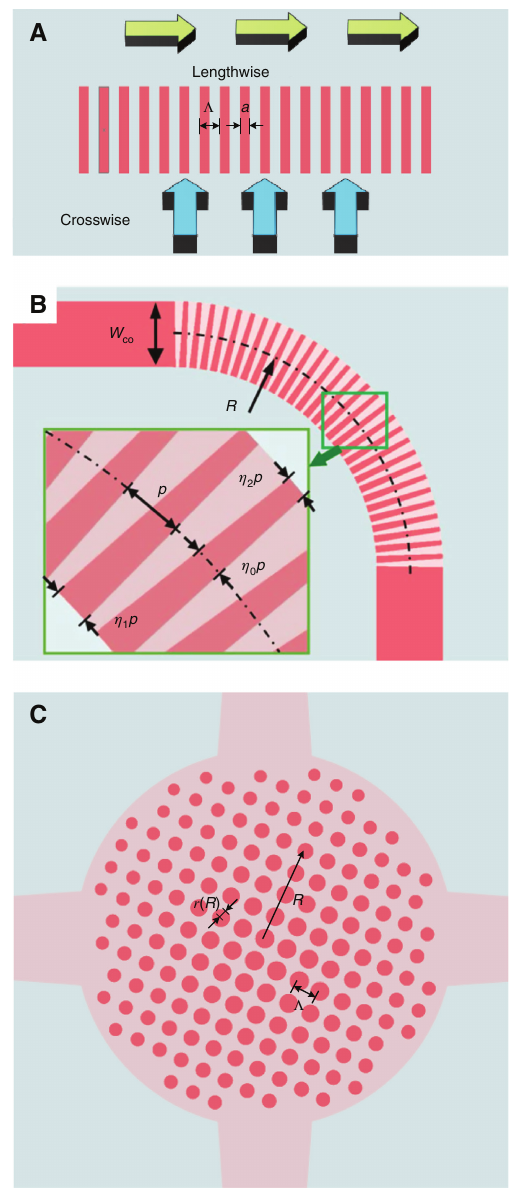
Figure 1: Schematic diagrams of various subwavelength structured strip and slab waveguides. (A) SWG waveguide, (B) 90 ° waveguide bend, and (C) multimode crossing based on the subwavelength metamaterial. The red, pink, and gray colors represent silicon, partially etched silicon, and silica, respectively. B is reprinted from Wu et al. [12]. reported in Xu and Shi